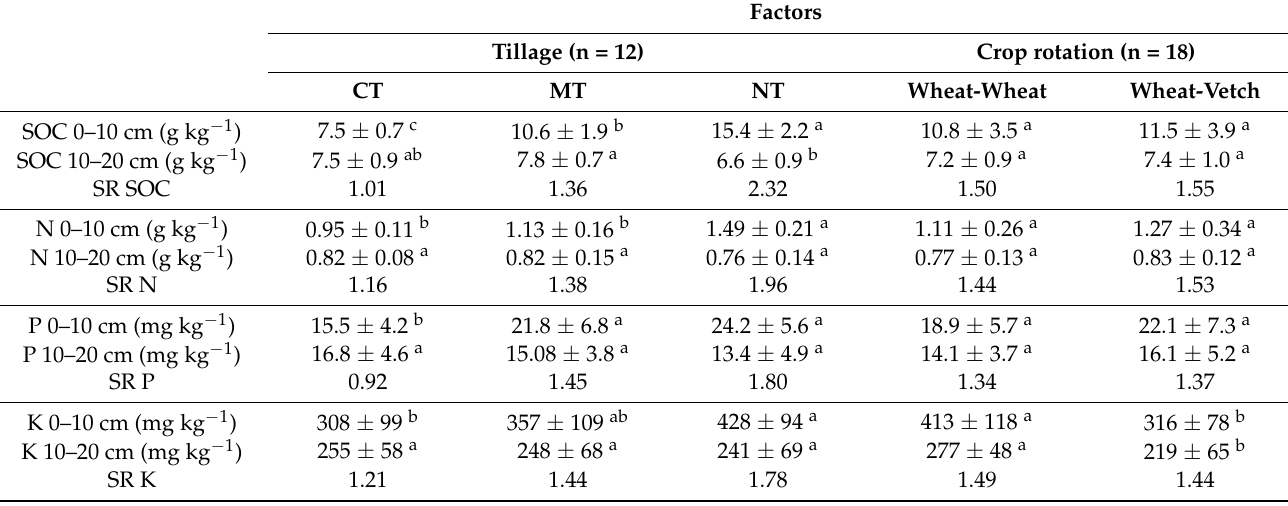
Table 2. Stratification relationships (SR: contents at 0–10 cm/contents at 10–20 cm) of SOC, total nitrogen (N), and available phosphorus (P) and potassium (K) under different tillage types and crop rotations. Data obtained from the last two years of the